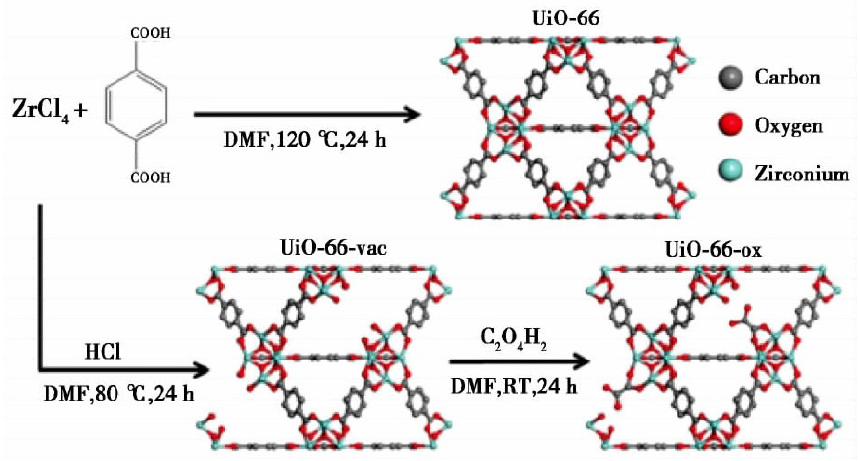
Figure 10. Synthesis of UIO-66, UiO-66-vac, and UiO-66-ox [101].